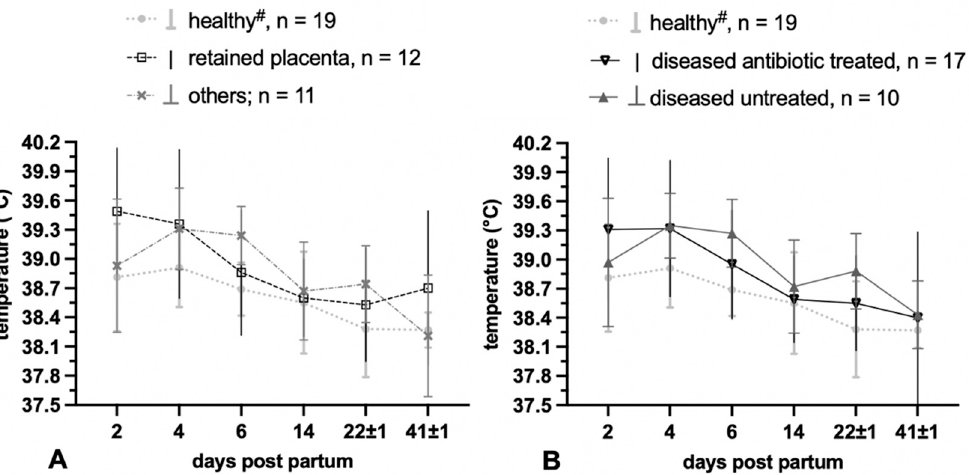
Percentages are given linewise; # two cows were treated with antibiotics only after sampling; TC = Tetracyclinhydrochlorid; BP = Benzylpenicillin-Procain; P = Penethamathydroiodid; bold: group of cows that remained healthy and group of cows that became diseased.